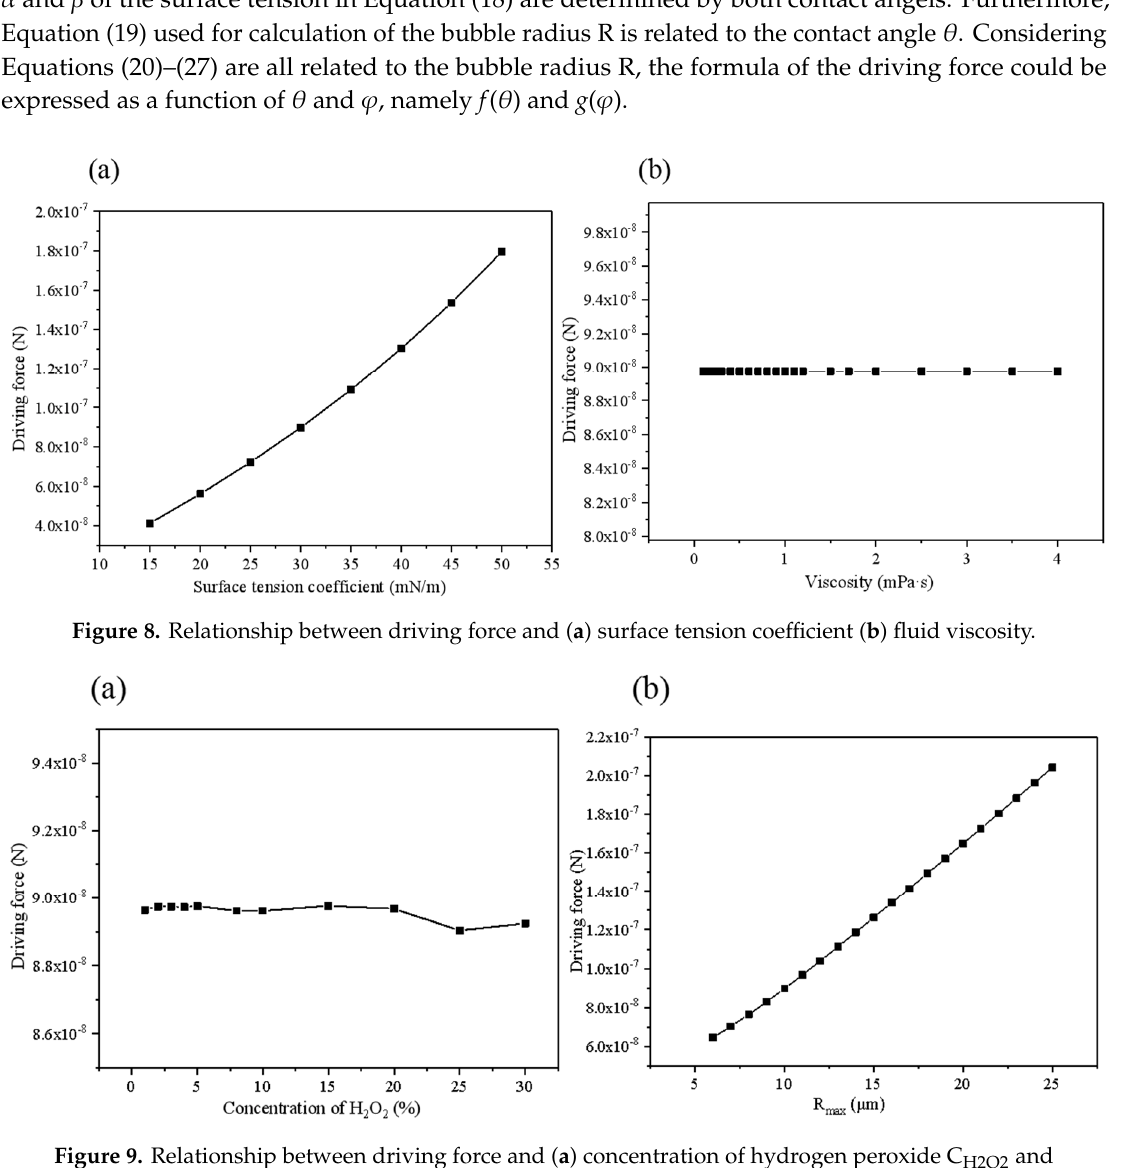
Figure 10. Relationship between driving force and ( a ) micromotor length ( b ) tangent semi-cone angle. Combing the relationship between F jet2 and σ as well as R max , the final expression of the driving force in the stage is